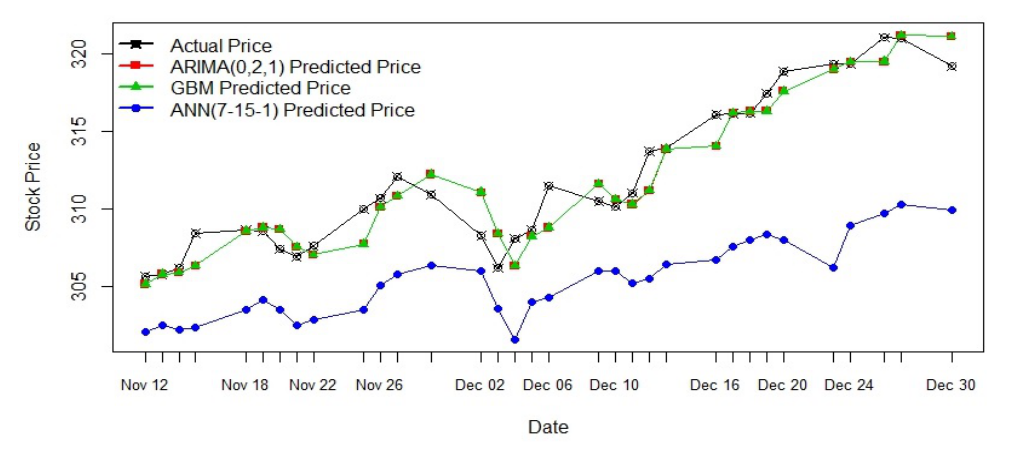
Figure 12. Prediction by all three models against the actual stock price.